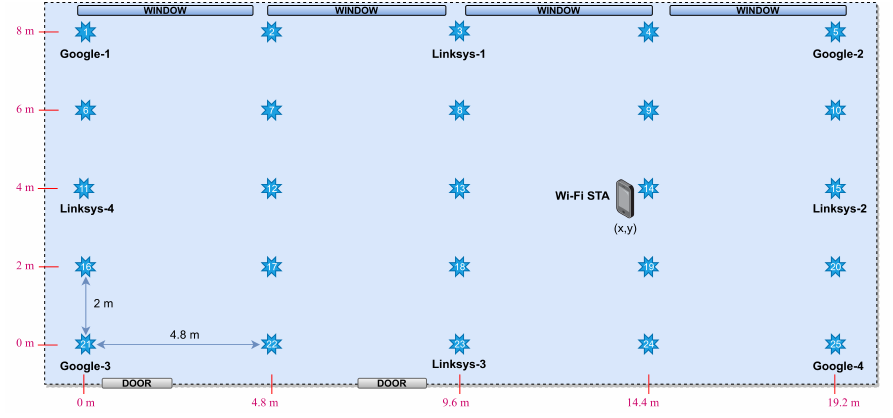
Figure 3. Scenario with four Google and four Linksys APs, and 25 reference points (blue stars).